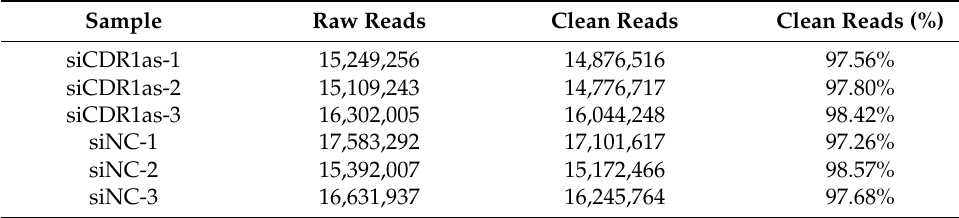
Table 1. Summary of reads from raw data and clean read for miRNAs (siCDR1as).